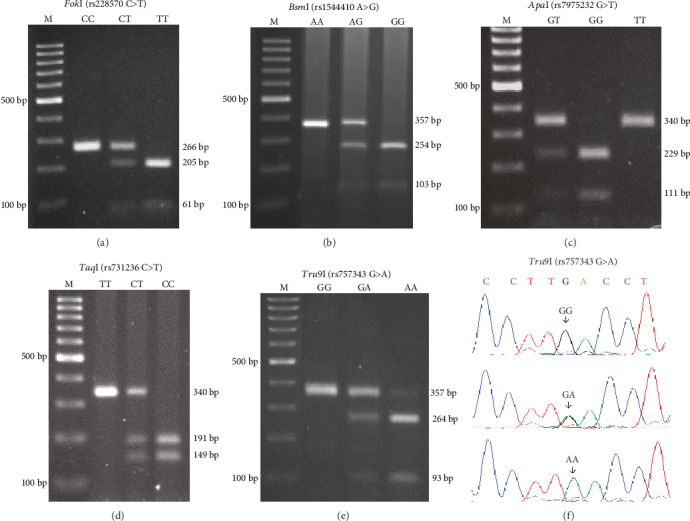
Representative RFLP patterns of each VDR polymorphism of the 5 VDR-SNPs and example of DNA sequencing results of three PCR products of three cases with different Tru9I genotypes. (a) FokI (rs228570 C>T): product sizes were 266 bp for the C allele and 205 and 61 bp for the T allele, (b) BsmI (rs1544410 A>G): product sizes were 357 bp for the A allele and 254 and 103 bp for the G allele, (c) ApaI (rs7975232 G>T): product sizes were 340 bp for the T allele and 229 and 111 bp for the G allele, (d) TaqI (rs731236 C>T): product sizes were 340 bp for the T allele and 191 and 149 bp for the C allele, (e) Tru9I (rs757343 G>A): product sizes were 357 bp for the G allele and 26 and 93 bp for the A allele, and (f) DNA sequencing results of the PCR products with Tru9I (rs757343 G>A) genotypes GG, GA, and AA. The arrow indicates the polymorphism; M: a molecular marker of the 100 bp ladder.